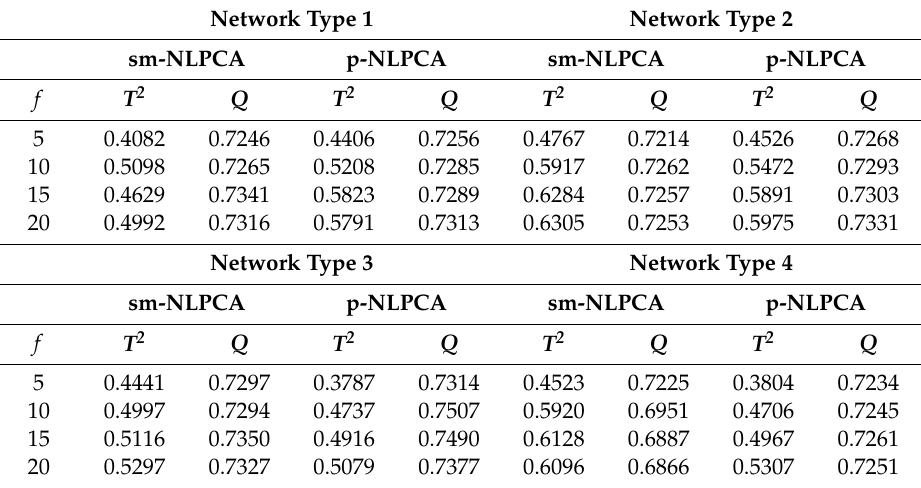
Table 6. Fault detection rates with adjusted upper control limits (FAR = 0.01 for normal test